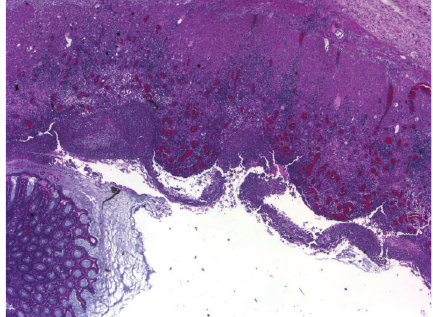
Figure 3: Ulceration of the colonic mucosa, low power